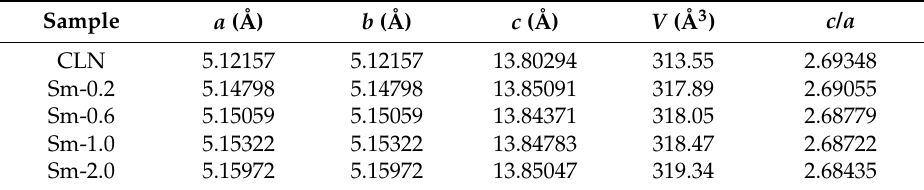
Table 1. The lattice constants of the crystal samples.